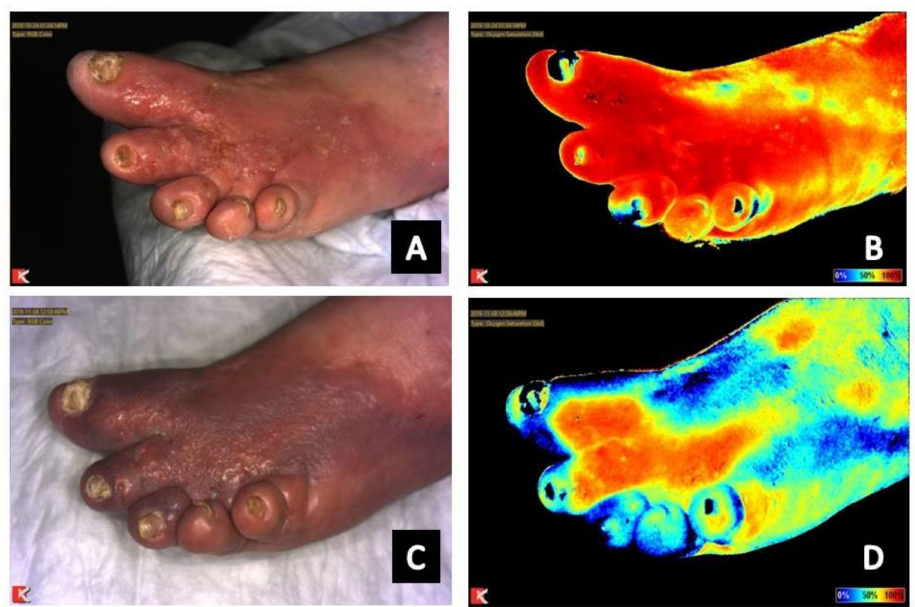
Figure 4. ( A ) Baseline clinical photograph; and ( B ) near-infrared image assessment of the left dorsal foot. Note on the near-infrared image the increased signal in signal on the dorsum of the foot secondary to skin and soft tissue infection. ( C ) Clinical photograph; and ( D ) near-infrared image assessment following initiation of antibiotic therapy. Note the reduction of signal on the dorsal foot following initiation of antibiotic therapy.